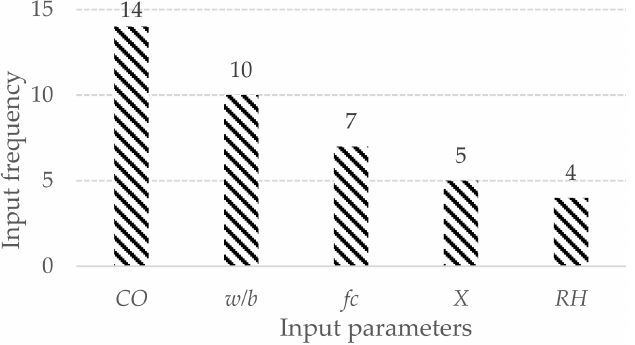
Figure 7. Input frequency of MGGP model parameters.